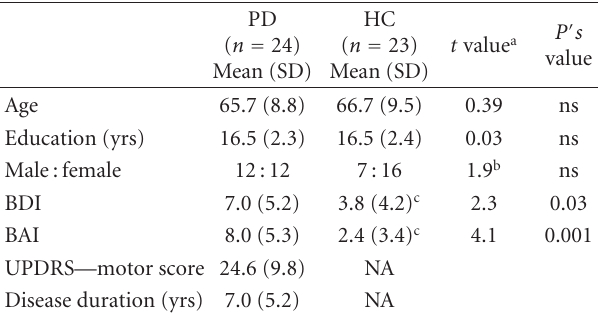
Table 1: Participant